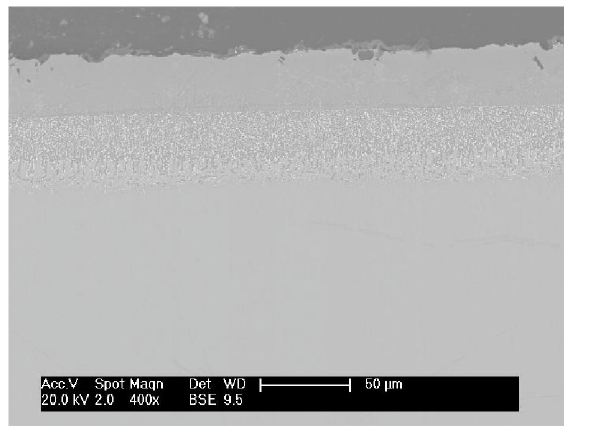
FIG. 2. THE CROSS-SECTION OF THE COATING DEPOSITED AT 1100 O C WHILE KEEPING ALL PARAMETERS SAME AS ONE SHOWN EARLIER FIG. 1(a-b)